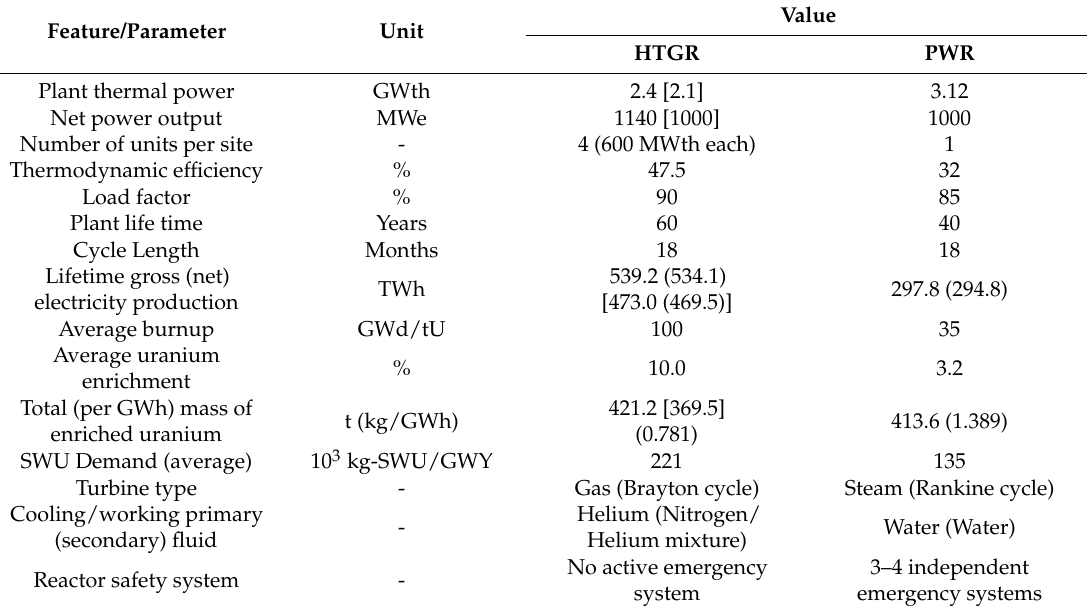
Table 1. The main characteristics of high temperature gas-cooled reactor (HTGR) power generation system (the characteristics of currently most popular pressurised water reactor system are shown for